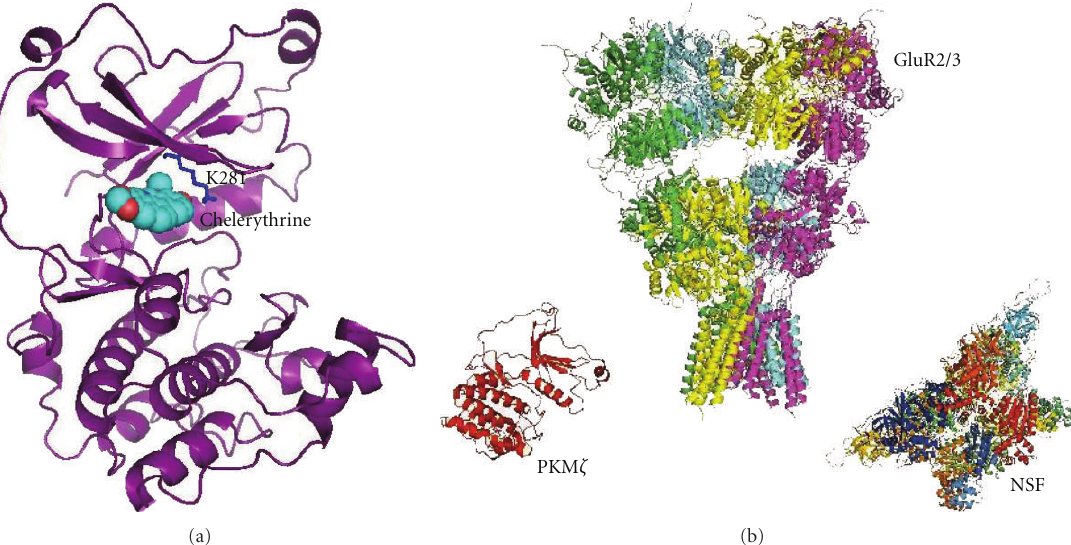
Figure 3: 3D models of proteins involved in the long-term memory maintenance: (a) human PKM ζ homology model based on PKC iota [1ZRZ.pdb]. The chelerythrine (sphere-filled model with the oxygen atoms shown as red spheres and carbon atoms as cyan) binding site was identified within the ATP-binding pocket of the PKM ζ (ribbons). Docking was performed using AutoDock software [117] and protein was visualized using PyMol. The inhibitor binding site is located in the vicinity of the Lys281 residue. K281W mutation renders PKM ζ inactive and causes permanent erasure of the long-term memory [118]. (b) The N-ethylmaleimide-sensitive factor (NSF) consists out of two hexameric Walker-type D1 and D2 domains (N-terminal NSF domain not shown). Its ATPase-catalytic activity is needed to release GluR2 subunit from endosomes and GluR2/3 assembly at the postsynaptic membrane. Crystallographic structure for the last 68 amino acids of the GluR2 C-terminal, including the NSF and AP2 binding sites, is not